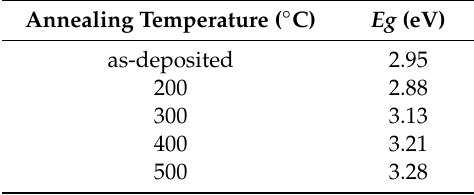
Table 2. E ff ects of annealing temperature on energy gap ( Eg ) of Ti:SnO 2